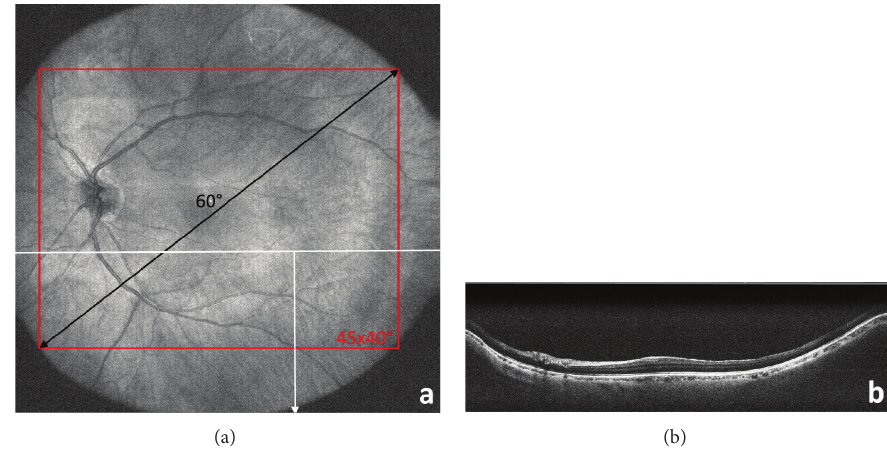
Figure 3: OCT images cover a field of view with a diameter of 60 ∘ which corresponds to 45 ∘ × 40 ∘ as shown in the en face reconstruction in (a). Cross-sectional views (B-frames) can be obtained at every location as seen in